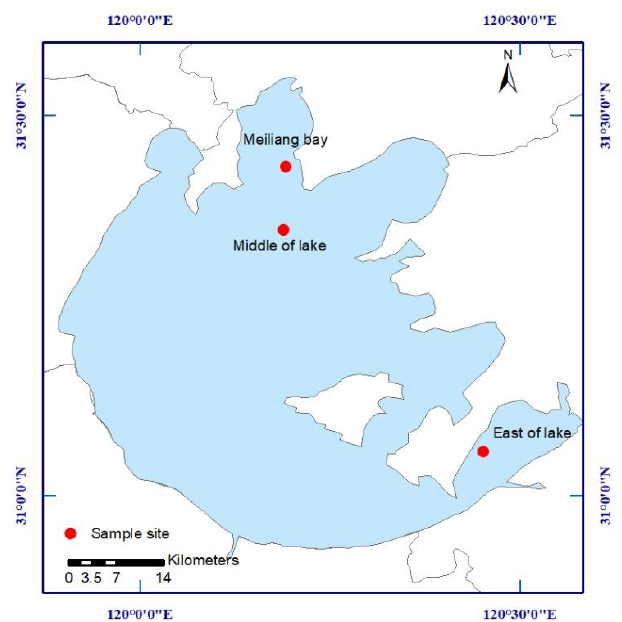
Figure 1. Location of sampling sites in Taihu